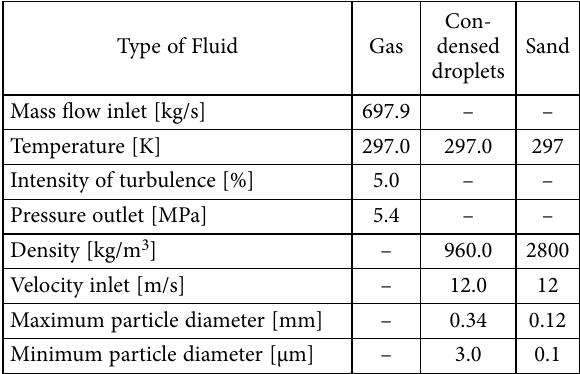
Table 1. Parameters used in CFD analysis of multiphase flow in the